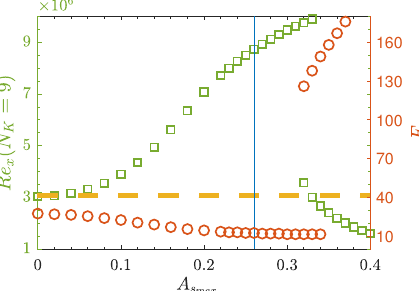
Figure 6. Shape mode of the perturbation for streaks with a peak intensity of A s 0.30 ( c ), and 0.36 ( d ). Top row corresponds to, for each streak, the streamwise location ((a) Re δ = 580, (b) Re δ = 555, (c) Re δ = 533 and (d) Re δ = 486) where maximum streak amplitude is reached. Bottom row stands for the streamwise position ((a) Re δ = 1236, (b) Re δ = 332, (c) Re δ = 843, and (d) Re δ = 976) where maximum N -factor is attained. Contour levels denote the 0.1,0.3,0.5,0.7,0.9 of the streamwise velocity component for each streak.